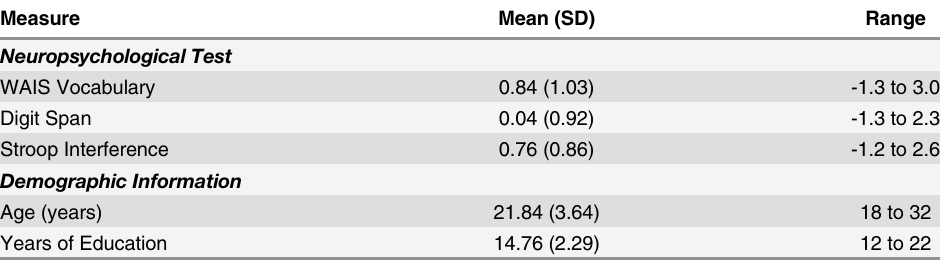
Table 2. Neuropsychological test results and demographic information for younger adults.